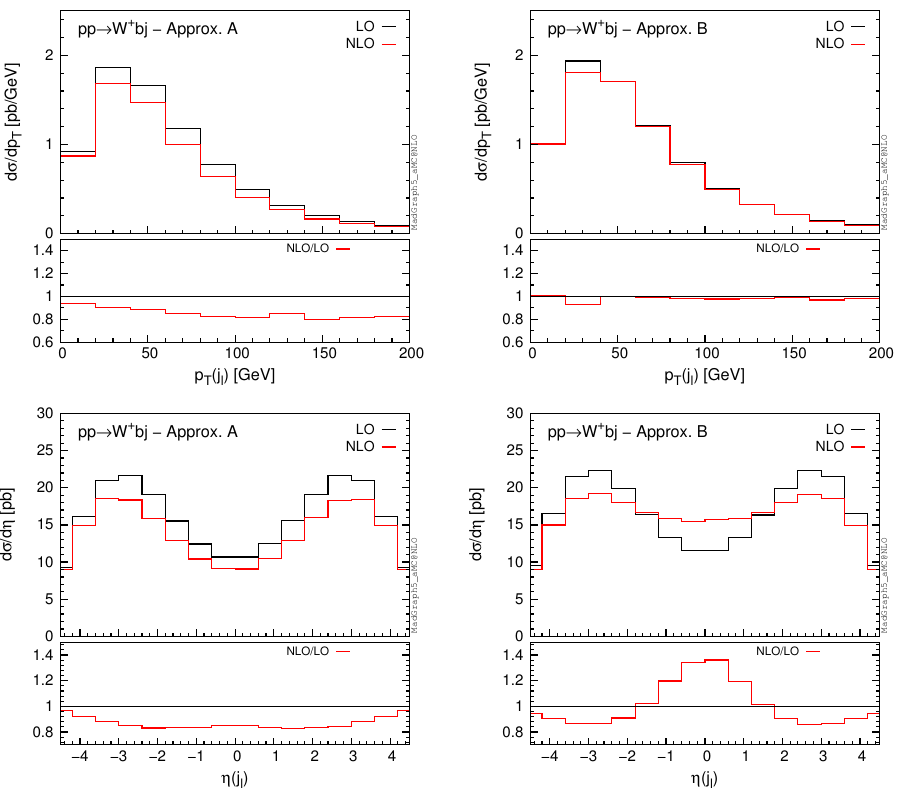
Figure 12 . The LO and NLO QCD predictions for the p T ( j l ) and (cid:17) ( j l ) distributions for the process pp ! tj l ( t ! Wb ) using Approximations A (left) and B